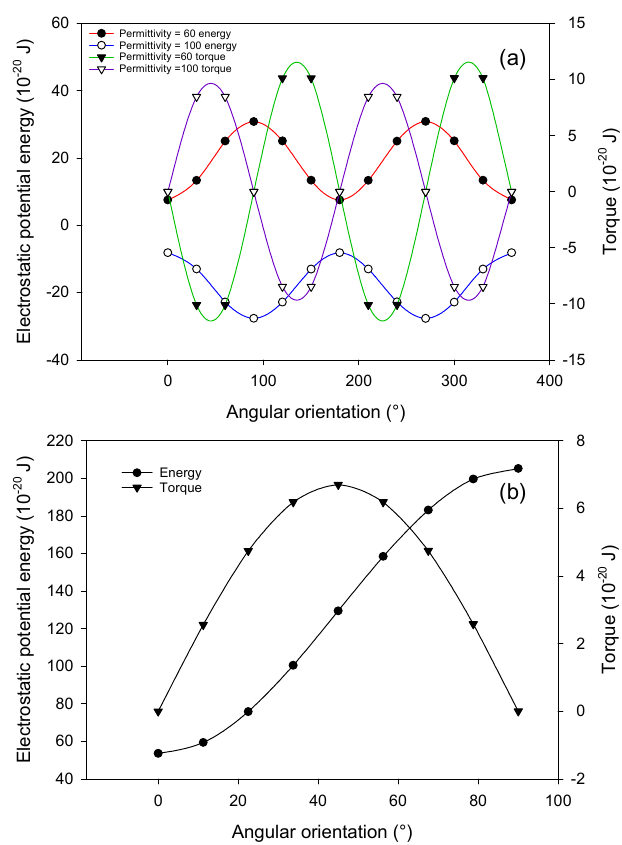
Figure 5. ( a ) Variation of electrostatic potential energy and torque of a single ellipsoidal particle when it rotates for 360°. ( b ) Variation of electrostatic potential energy and torque of the middle spherical particle in three-particle chain when the chain rotates for 90°.